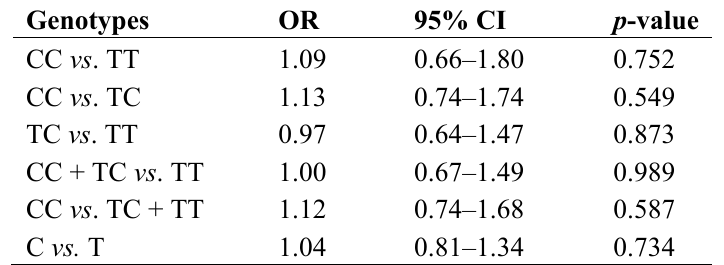
Table 2. Odds ratios, 95% confidence intervals and p -values for the association of CYP19 rs10046 genotypes and alleles with breast cancer